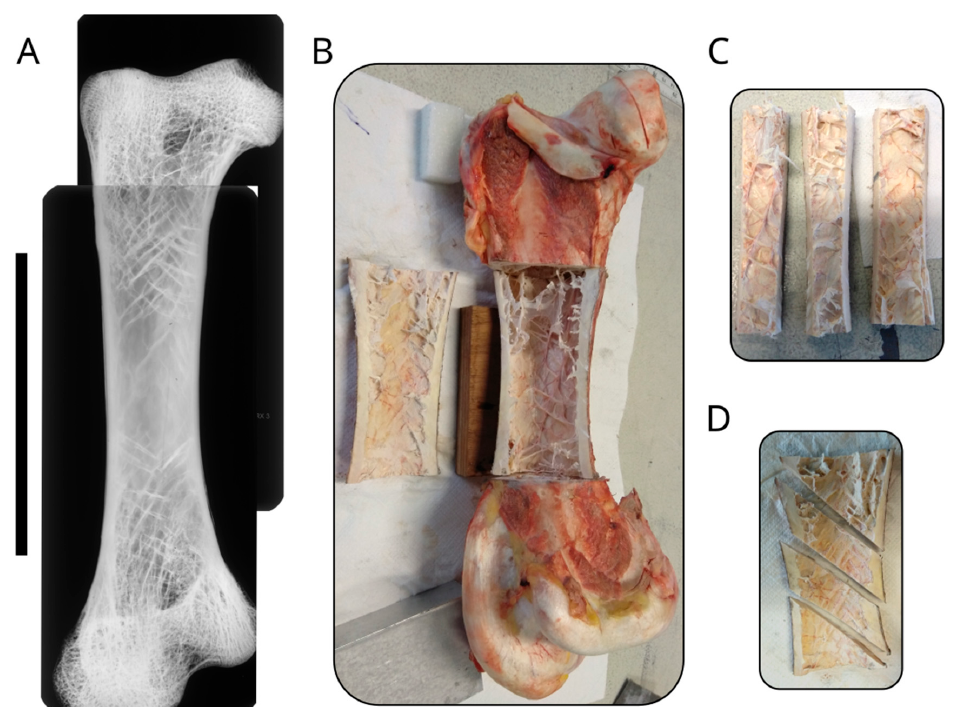
Figure 2. Structure of the ostrich femur. ( A ) Image composed of multiple radiographic images of an ostrich femur, showing the distribution of the trabeculae. The scale bar is equal to 10 cm. ( B ) Photo of the sectioned femur showing the marrow cavity with the oriented trabeculae. ( C ) Photo of the samples oriented alongside the long axis of the femur. ( D ) Photo of the samples oriented at 45° with respect to the long axis of the bone.